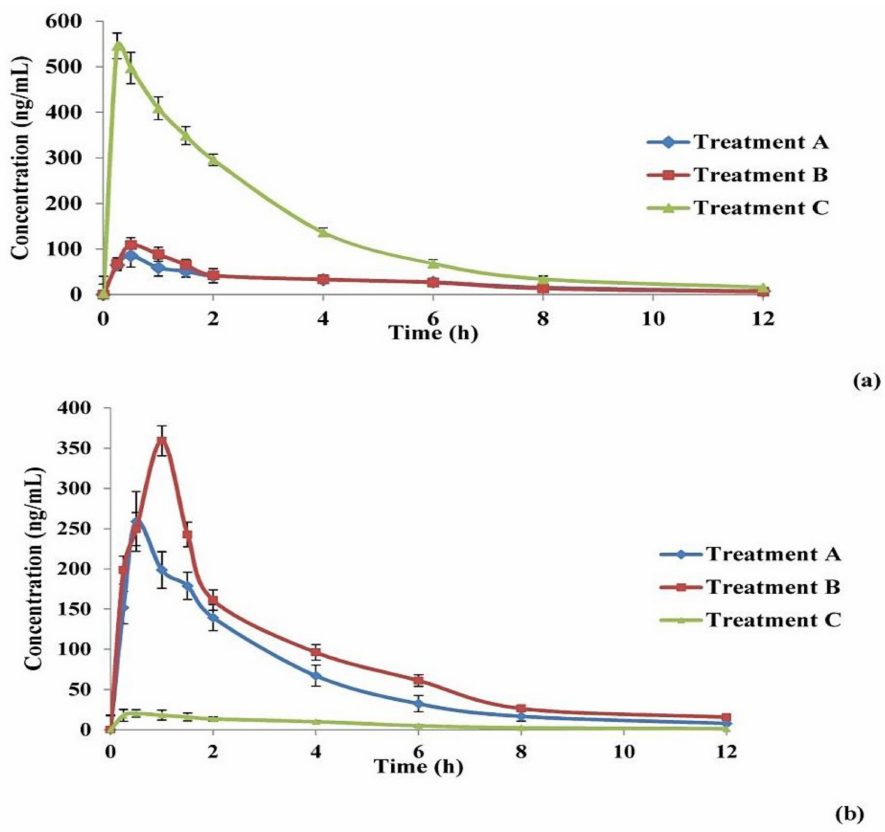
Figure 6. Zolmitriptan concentration versus time curves for plasma ( a ) and brain tissues ( b ) after administration of intranasal optimal bilosomes (Treatment A), intranasal mucoadhesive in situ gelling system (Treatment B), and intravenous zolmitriptan solution (Treatment